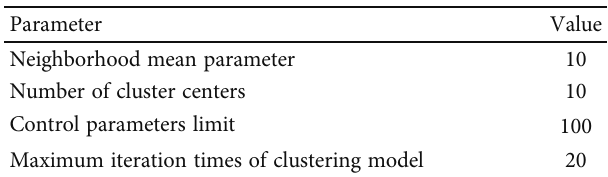
Table 2: Parameter